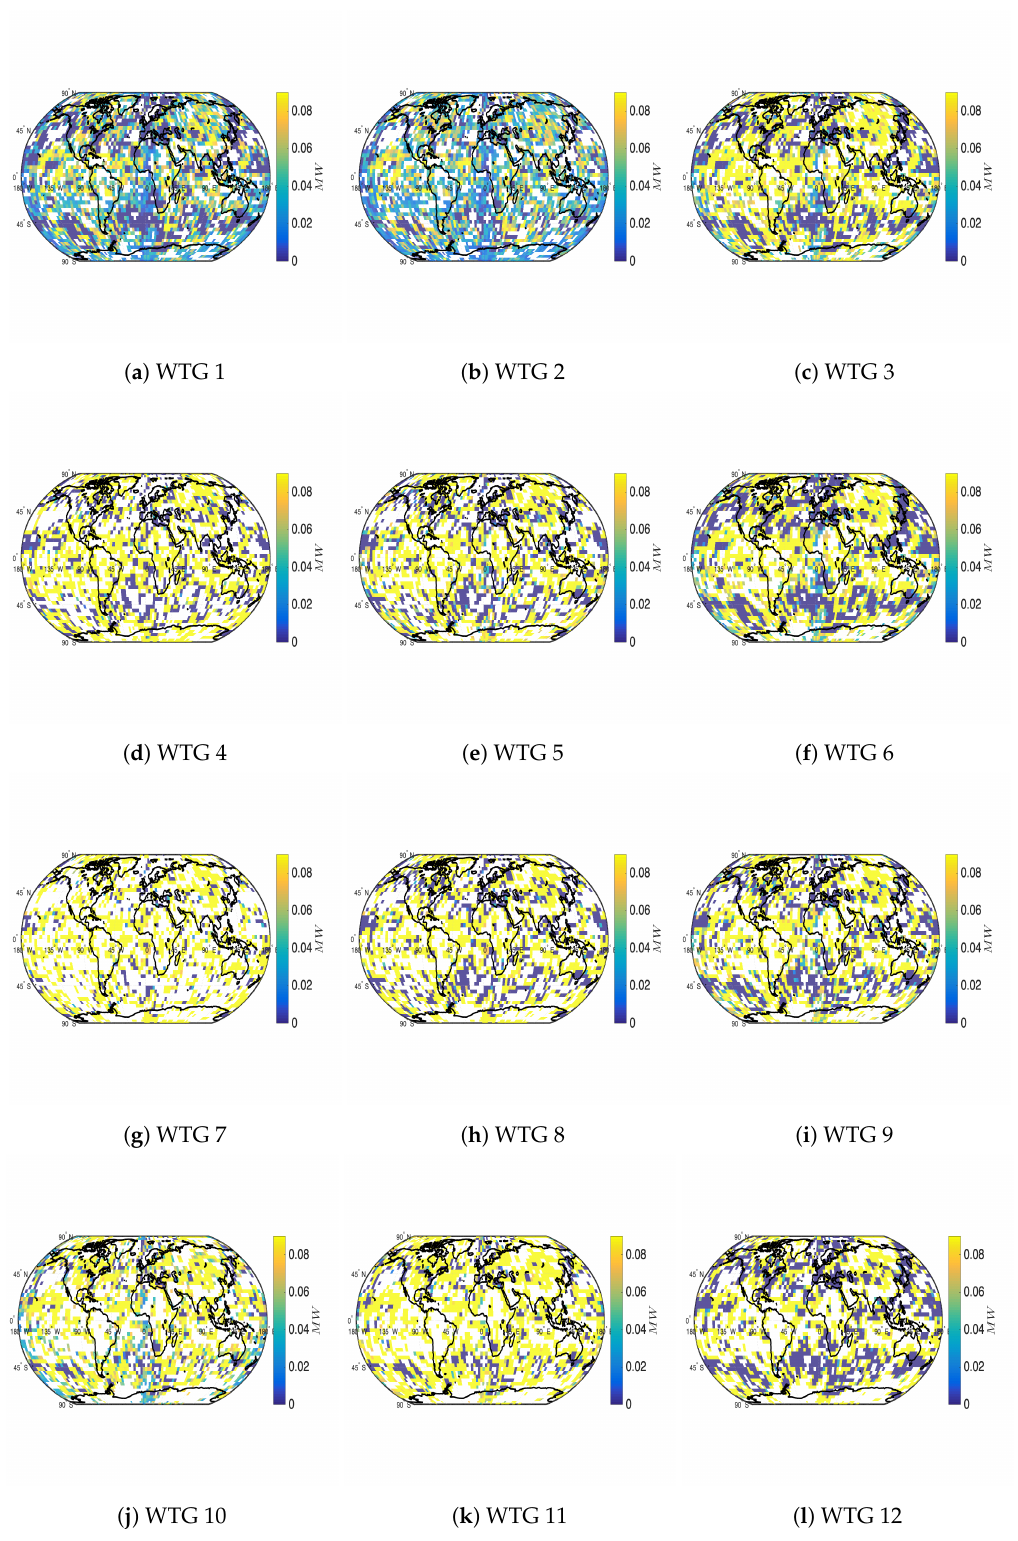
Figure 8. Mean of wind energy potentials for the 4D-Var-MC implementations. The number of ensemble members N = 20. White regions denote no wind-energy-potential generation. The number of observations reads 1. ( a ) WTG 1; ( b ) WTG 2; ( c ) WTG 3; ( d ) WTG 4; ( e ) WTG 5; ( f ) WTG 6; ( g ) WTG 7; ( h ) WTG 8; ( i ) WTG 9; ( j ) WTG 10; ( k ) WTG 11; ( l ) WTG